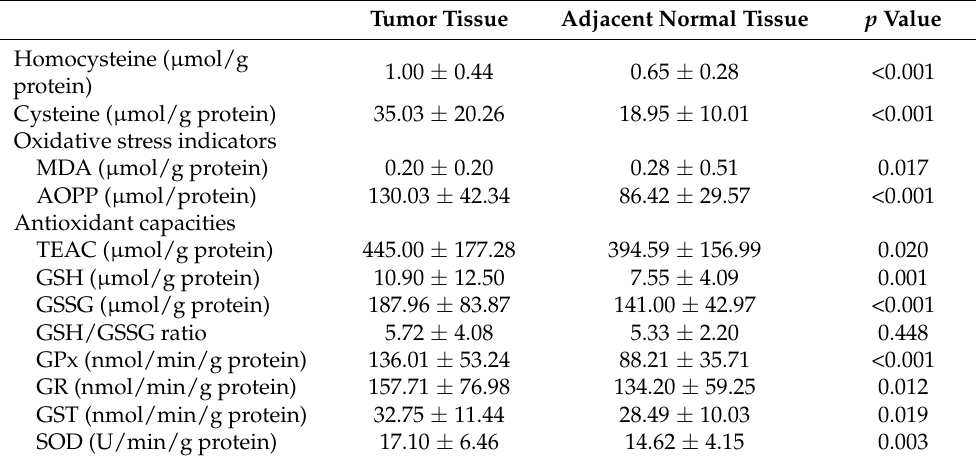
Table 3. Cysteine, homocysteine, indicators of oxidative stress, and antioxidant capacities in colorectal tumor tissues and adjacent normal tissues.